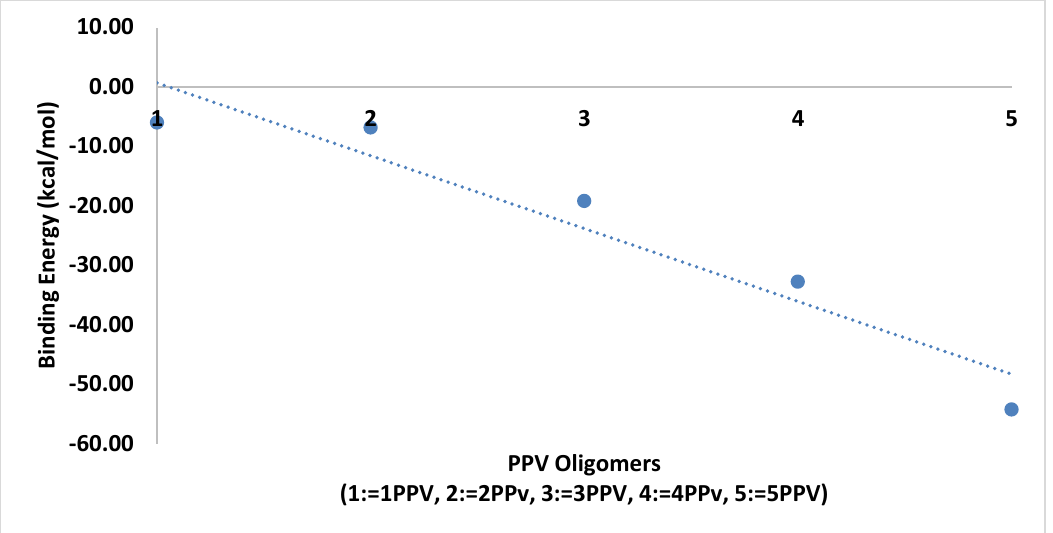
Figure 20. Binding energy PPV oligomers–graphene.